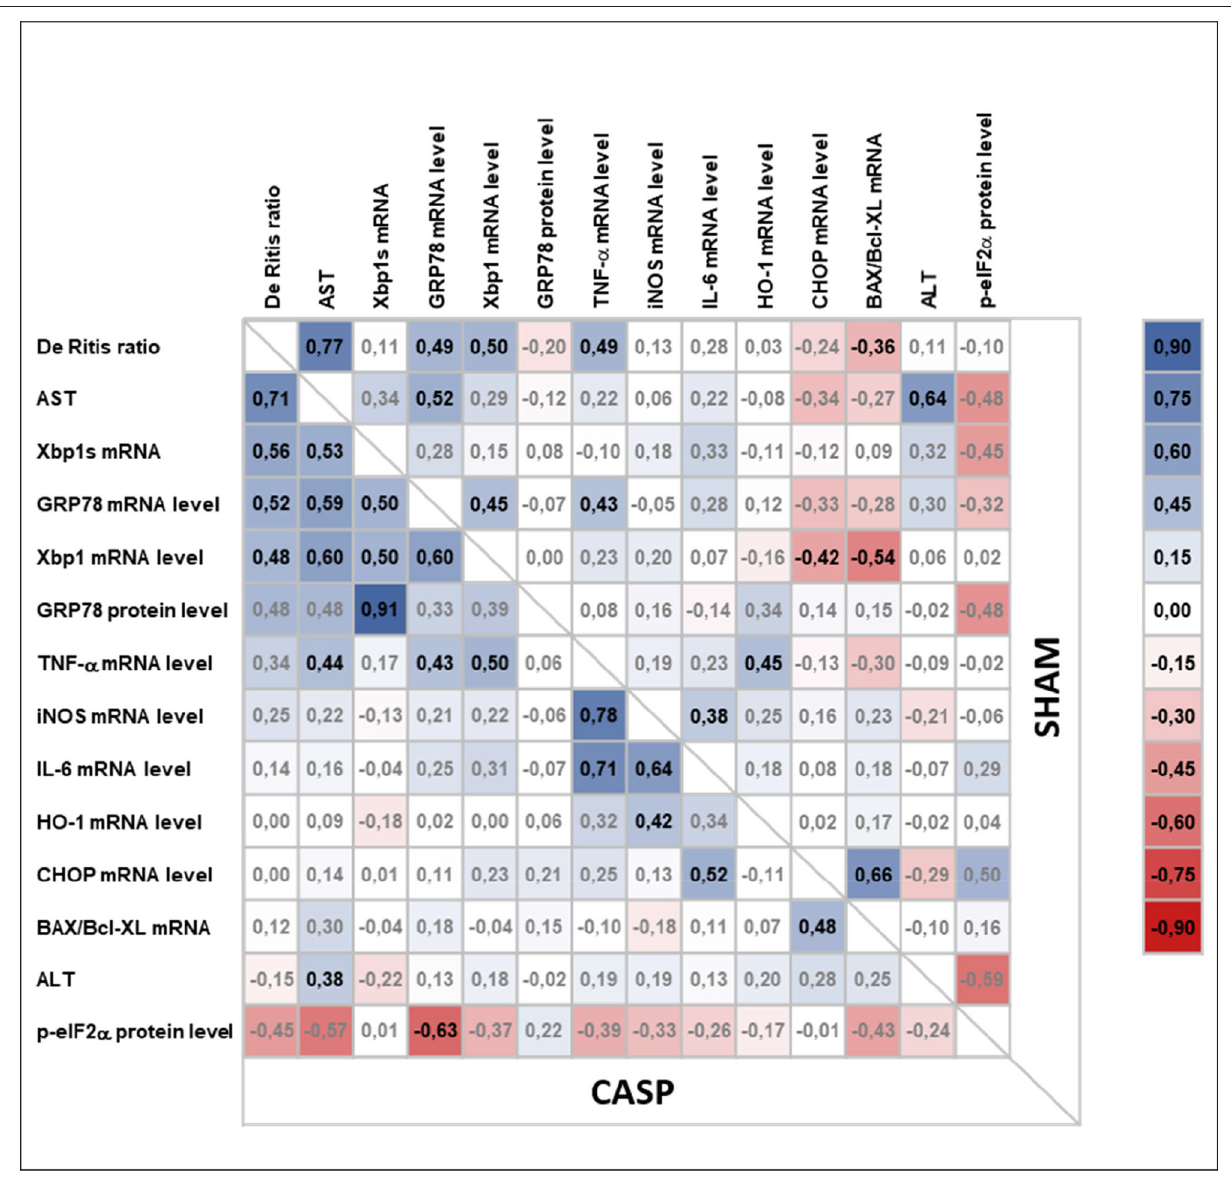
FIGURE 6 | Pearson correlation analysis of liver damage markers, UPR, and inflammatory response in animals subjected to surgery (sham) or CASP. Markers for organ damage (plasma ALT and AST and De Ritis ratio) and levels of hepatic markers for UPR (XBP1s mRNA, XBP1 mRNA, GRP78 mRNA/protein, p-eIF2 α protein, CHOP mRNA), inflammatory response (IL-6 mRNA, TNF- α mRNA, iNOS mRNA), general stress response (HO-1 mRNA), as well as BAX/Bcl-XL mRNA ratio as a marker for a proapoptotic phenotype were correlated with each other in both, CASP and sham animals, using Pearson correlation ( n = 4–8 for all mRNA data, n = 1–3 for all the protein data). In the upper right and the lower left part correlation coefficients ( r ) calculated from sham and CASP animals, respectively, are shown. A correlation plot was prepared using Microsoft Excel 2016. Positive correlations are highlighted in blue, negative correlations in red. Significant correlations are indicated by bold